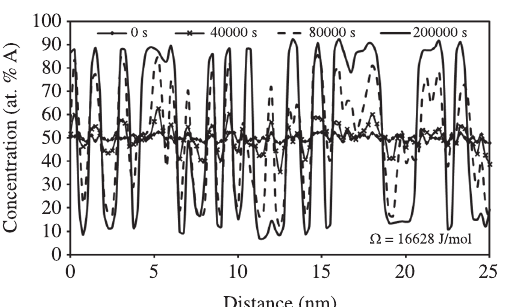
Figure 3. Concentration profile of the A-50at. % B alloy aged at 650 K for different times for Ω